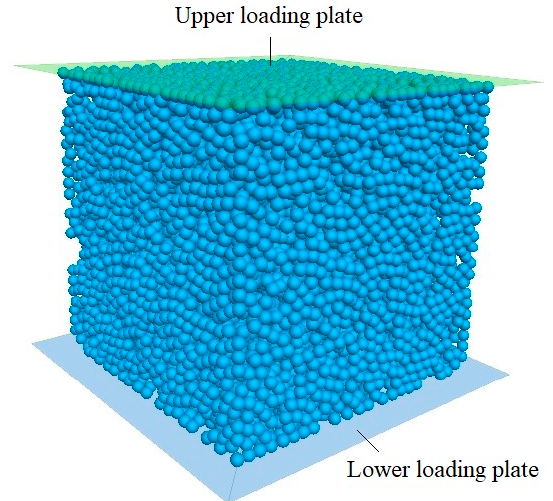
Figure 20. The calculation model for uniaxial compression of cube specimens.